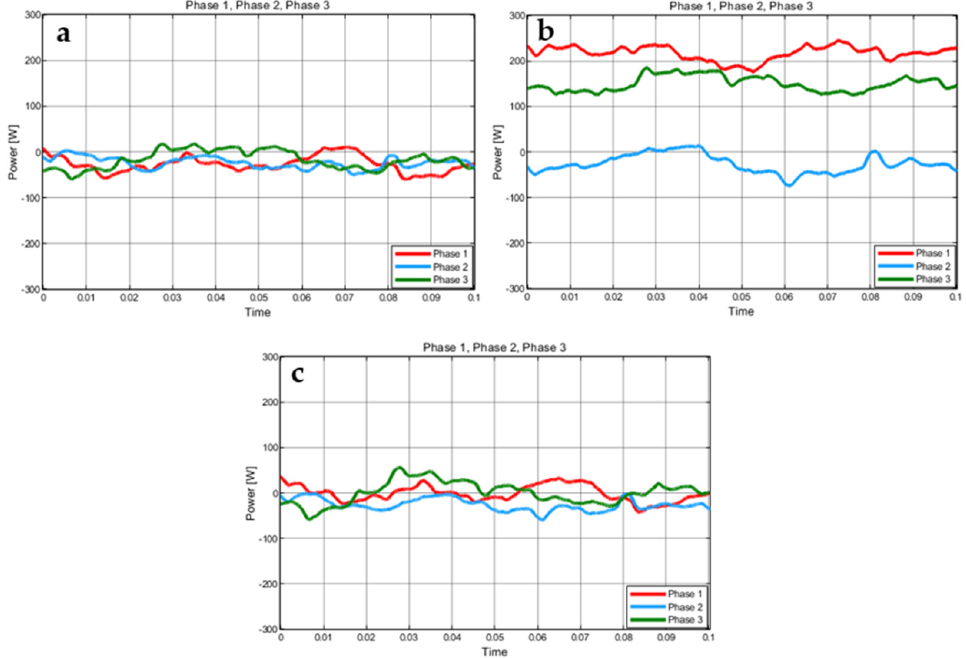
Figure 9. The results of simulation tests for ( a ) symmetrical loads and standard PLL, ( b ) asymmetrical loads and standard PLL, ( c ) asymmetrical loads with proposed three individual PLLs.